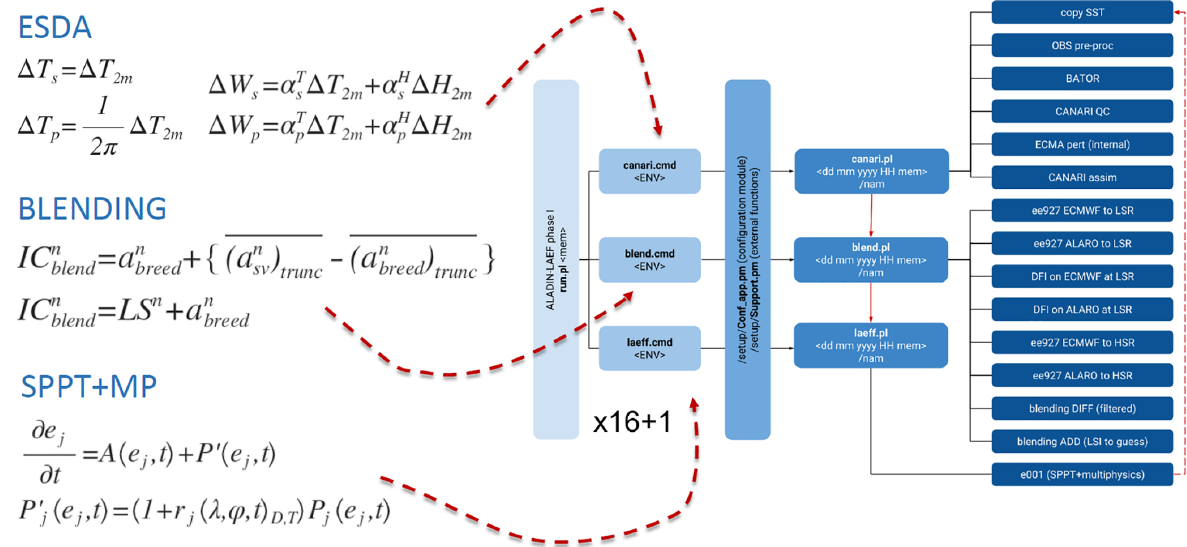
Figure 6. The scripting system of new ALADIN-LAEF Phase I configuration.